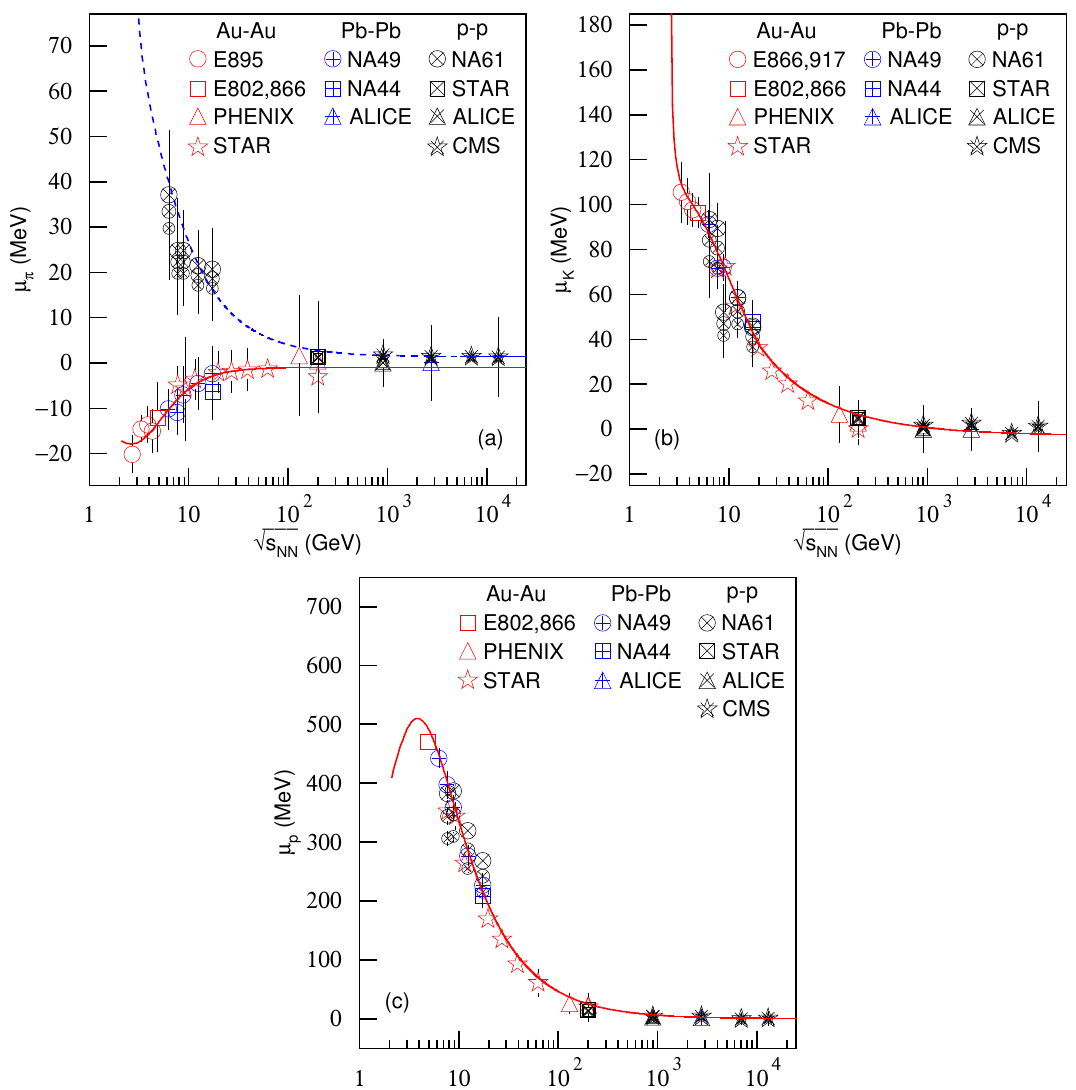
Figure 2. Chemical potentials: ( a ) µ π ; ( b ) µ K ; and ( c ) µ p , of ( a ) π ; ( b ) K ; and ( c ) p produced in mid-rapidity interval (in most cases) in central Au–Au (Pb–Pb) and INEL or NSD pp collisions at high energies. The symbols denote the derivative data obtained from Figure 1 according to Equation (5). In particular, the NA61/SHINE data appear in the forward rapidity region (in the center-of-mass system), although the experiment can provide results with 4 π geometry. The normal, medium, and small symbols with diagonal crosses denote the derivative data in INEL or NSD pp collisions obtained by T ch , 0.9 T ch , and 0.8 T ch in Equation (5), respectively. The curves surrounding the symbols are the derivative results obtained from the curves in Figure 1 according to Equation